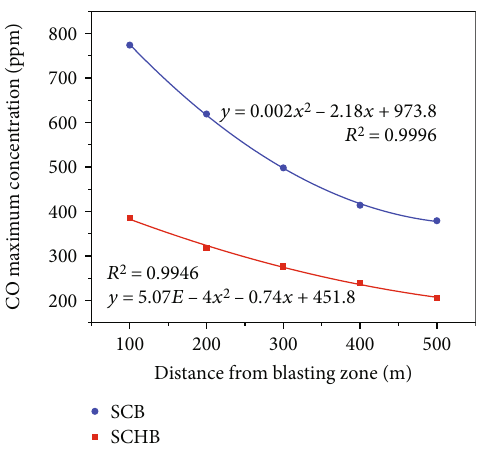
Figure 22: Changes in maximum CO concentration with monitoring distance in six-hole SCB and SCHB.